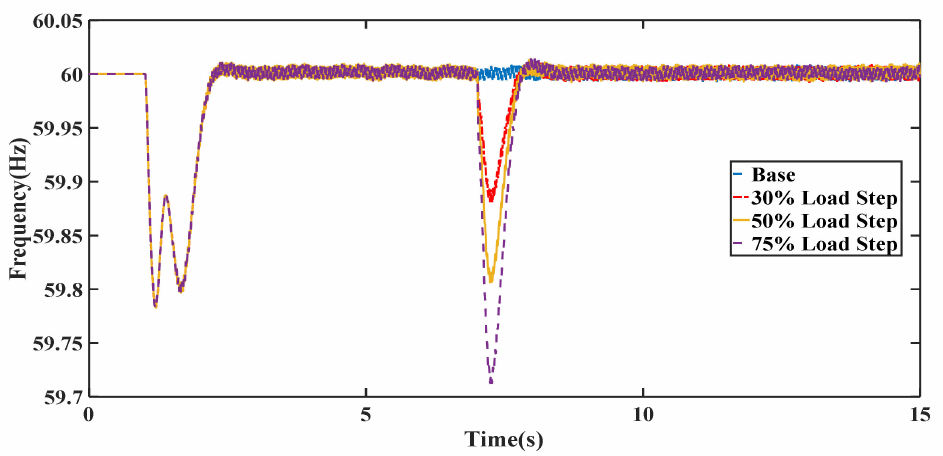
Figure 12. MG frequency excursion for various load steps in the islanded mode.